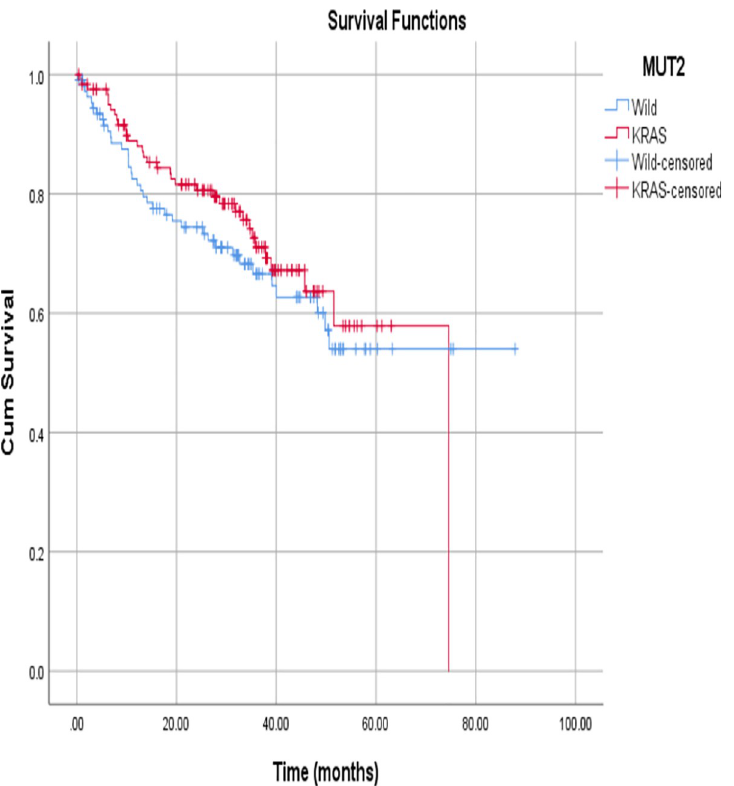
Fig 3. A Kaplan Meier analysis of KRAS mutated tumours vs wild-type tumours.